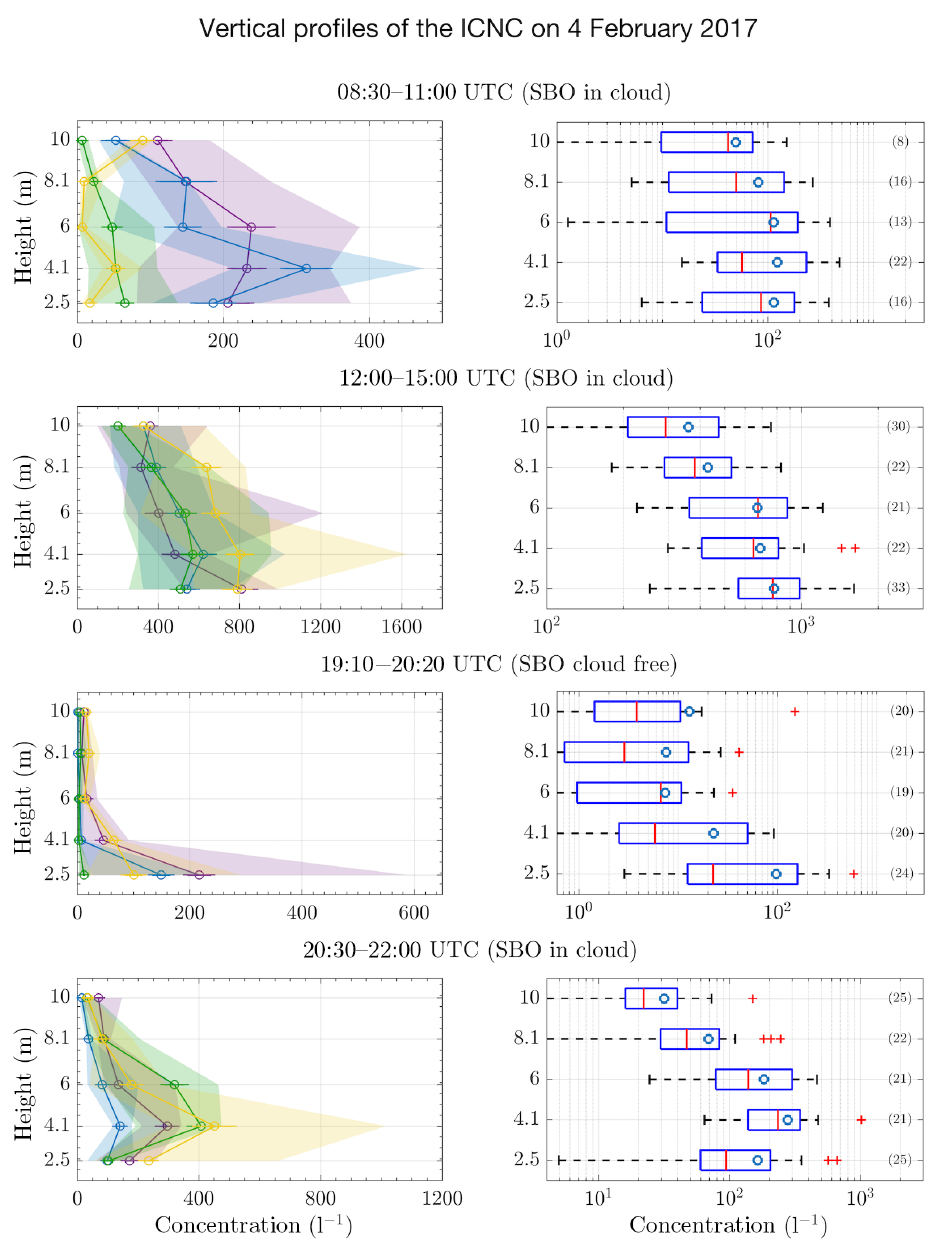
Figure 7. ICNCs as a function of the height of the elevator for four different time intervals during 4 February, representing different conditions (Fig. 4). From the 24 profiles observed on 4 February 2017 the individual profiles (left) show only 16 for better readability of the figure. The circles indicate the mean and the error bars the standard error of the mean. The shaded areas extend from the minima to the maxima of the measured ICNCs. Each color represents one profile with the elevator in the corresponding time interval. The box plots (right) show a summary of all 24 profiles in the respective time interval as in Fig.